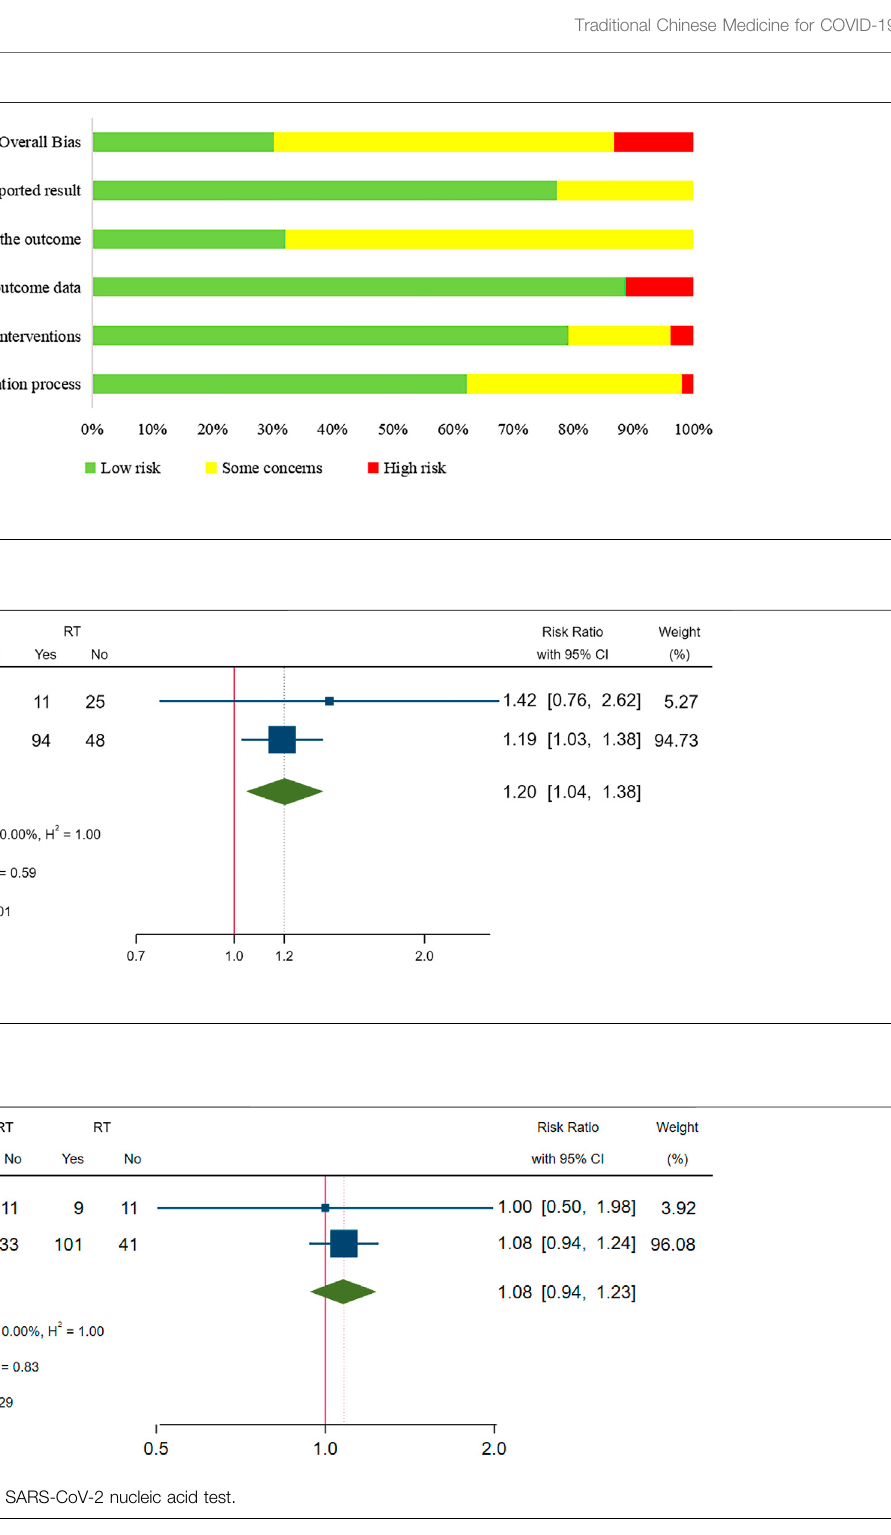
Frontiers in Pharmacology |